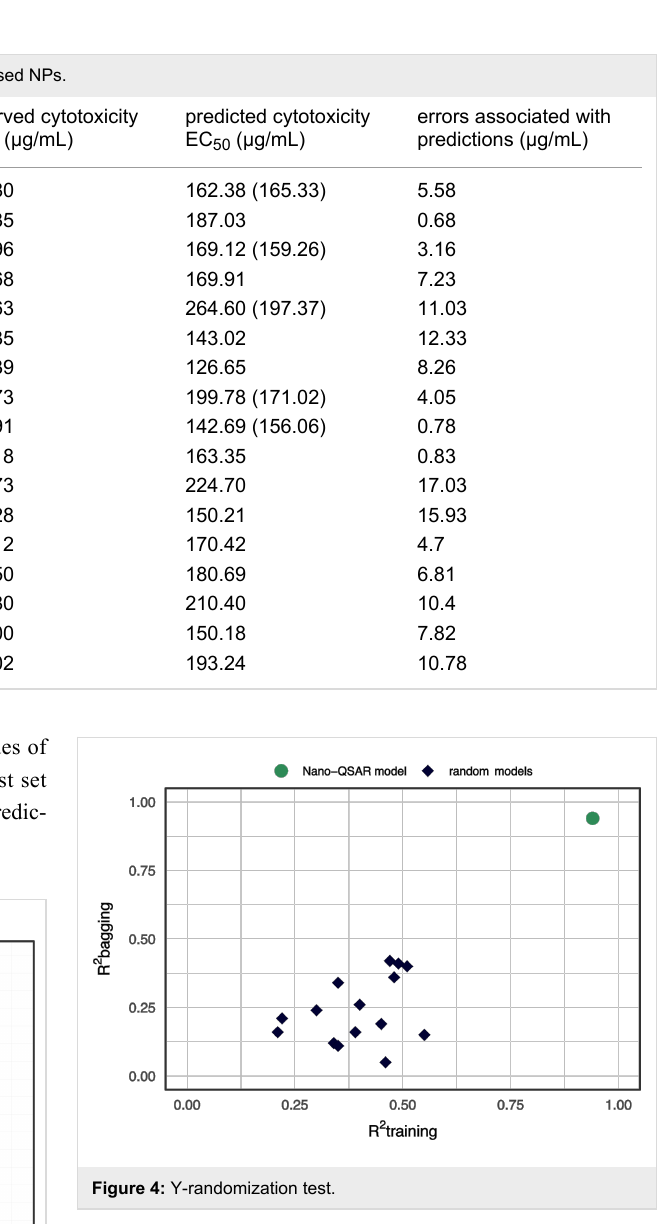
Figure 3: Plot of experimentally determined (observed) vs predicted values of cytotoxicity based on developed nano-QSAR model.